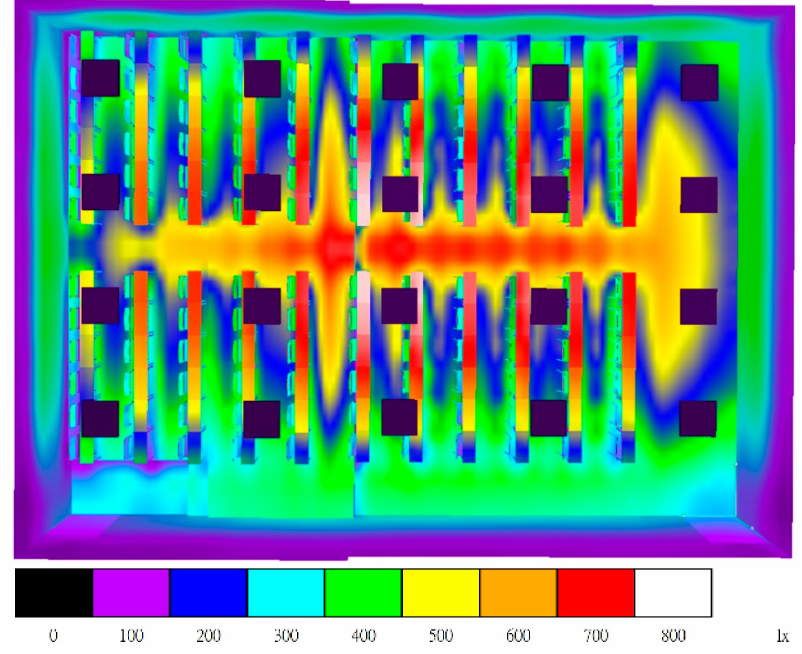
Figure 13. Color rendering of TR-214 classroom after lighting